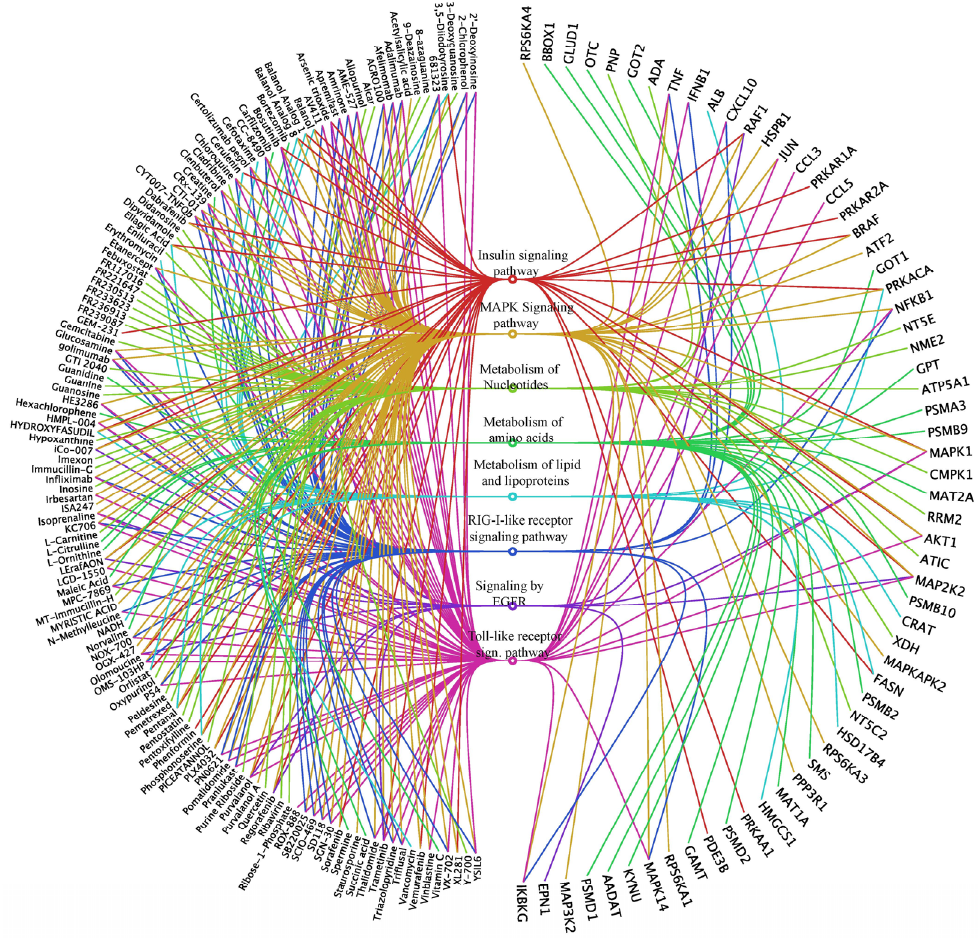
Figure 2. An “eye diagram” showing representative pathways, proteins and compounds, which can be potentially used for modulation of IAV–host interactions. The signaling/metabolic pathways are represented as various colored circles in the middle of the eye diagram. The colored curved lines originating from the pathways connect corresponding compounds on left to target proteins on right. Only the compounds that have shorter names are included for the sake of clarity.